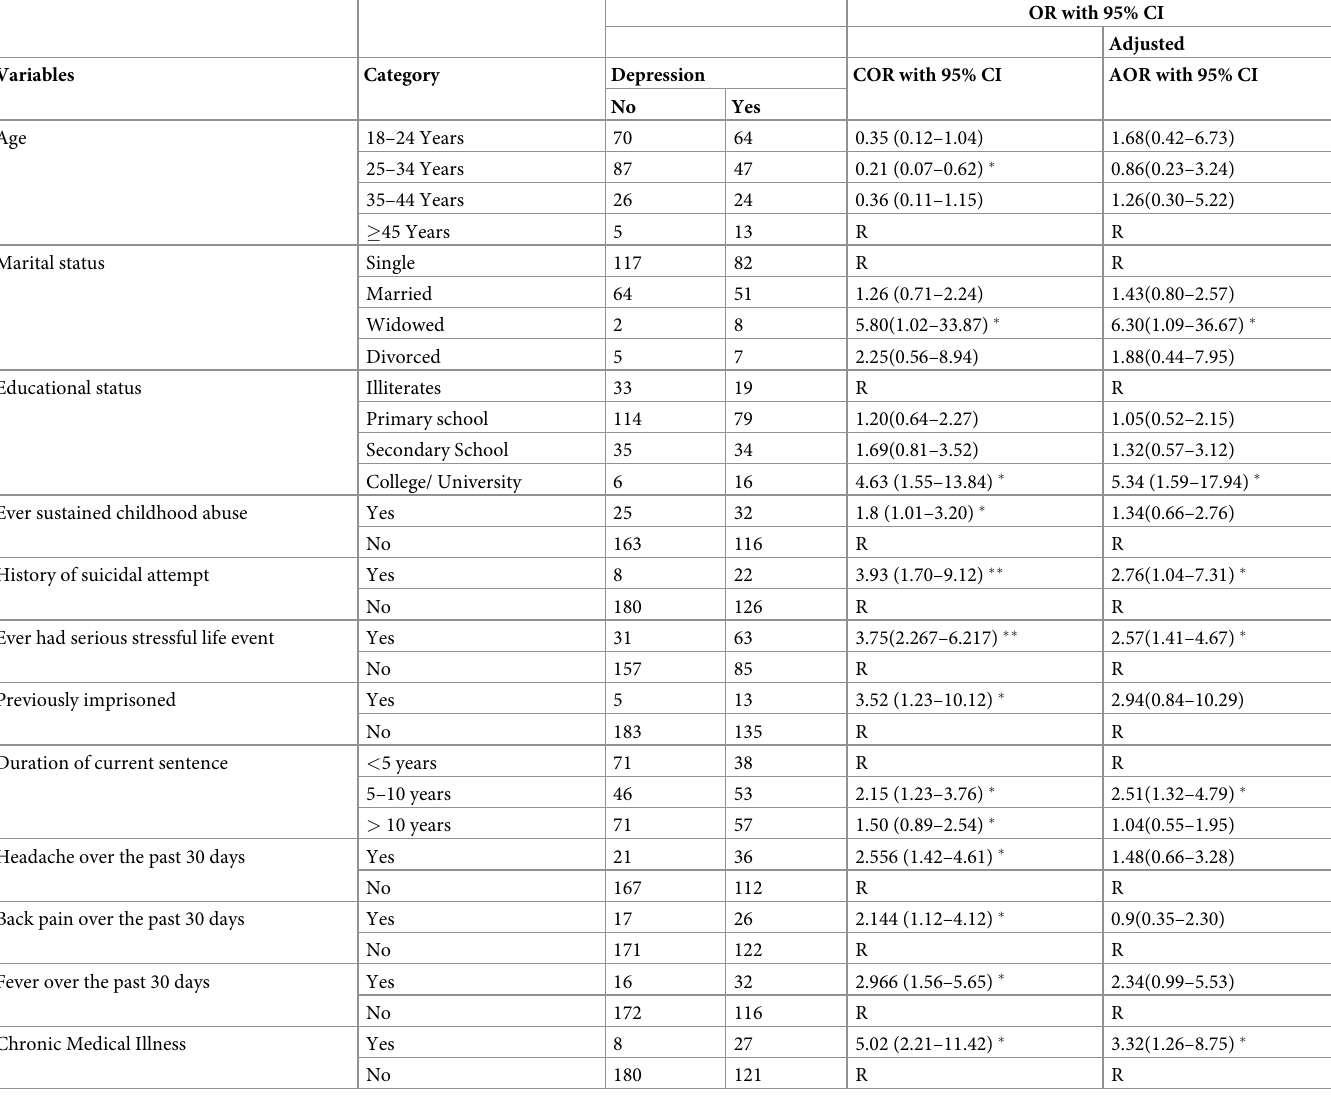
Table 3. Multi-variable binary logistic regression analysis of factors associated with depression among prisoners of Debre Berhan prison, Ethiopia,